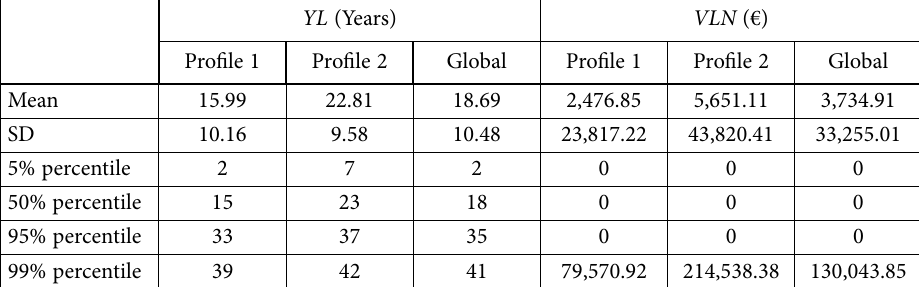
Table 7. Statistics of YL and VLN with RM (source: own elaboration)